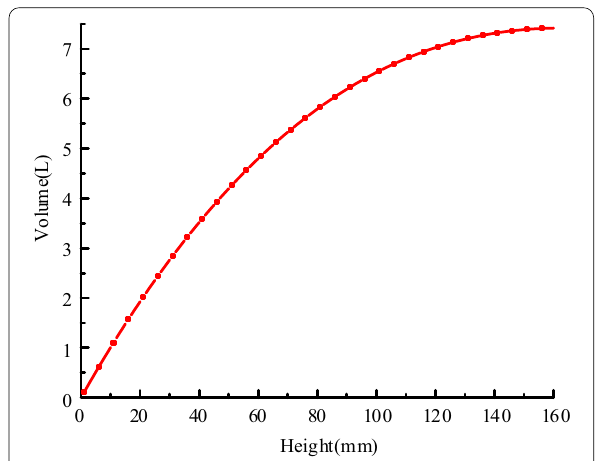
Figure 9 The simulation curve of volume change with